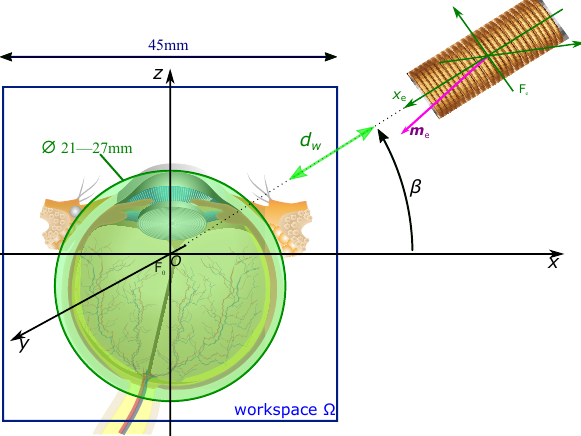
Figure 3. Representation of the workspace with respect to the eye